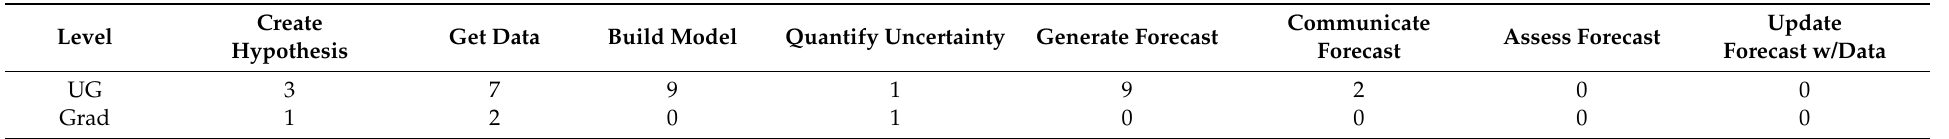
Table A9. Number of students out of the total undergraduate (UG, N = 112) and graduate student (Grad, N = 24) populations who included each step in the forecast cycle in their pre-module questionnaire but not in their post-module questionnaire.